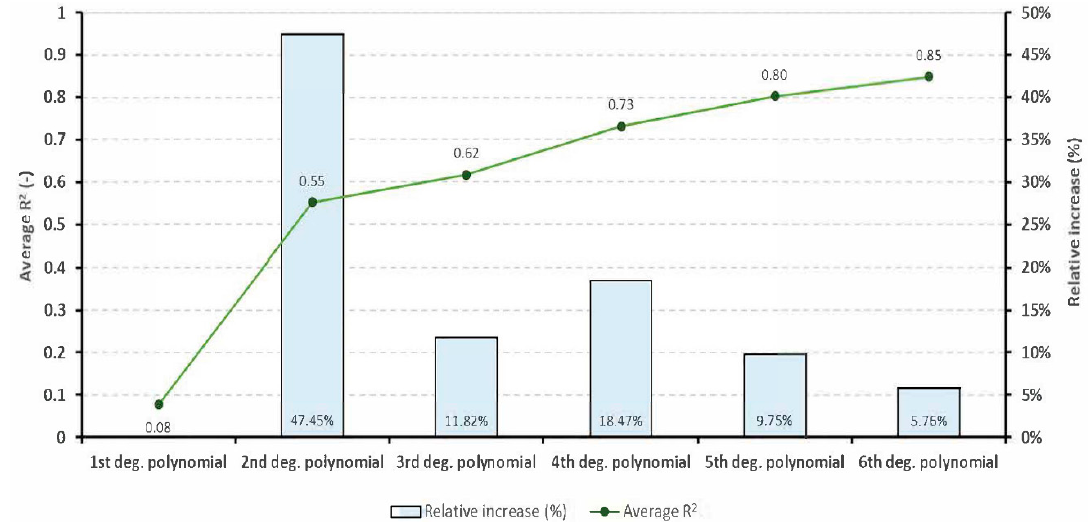
Figure 3. Average statistic estimator R 2 value for each adjustment polynomic function.